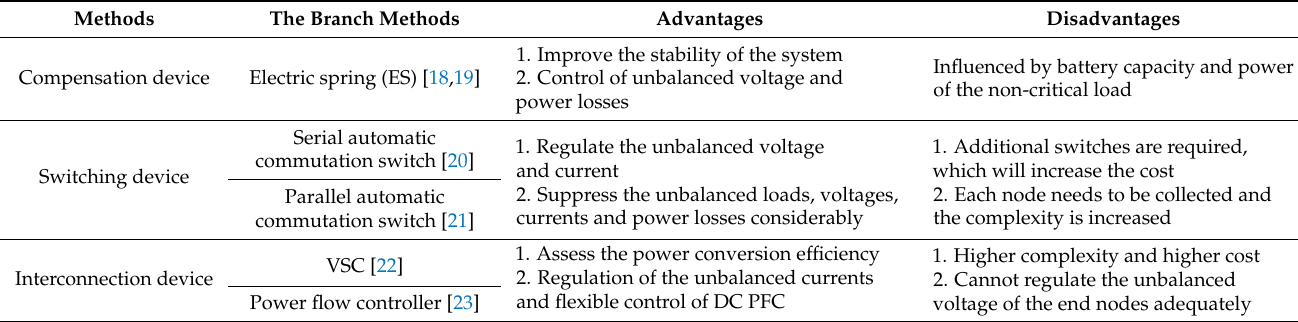
Table 1. Comparison of different unbalanced voltage control